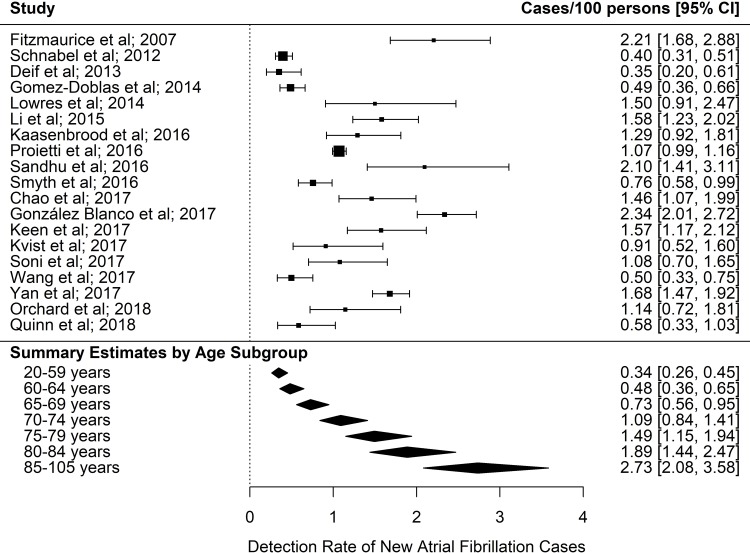
AF detection rate (adjusted for age and sex).Summary estimates are calculated from the 18/19 studies that provided both gender and age for total numbers screened. AF, atrial fibrillation.